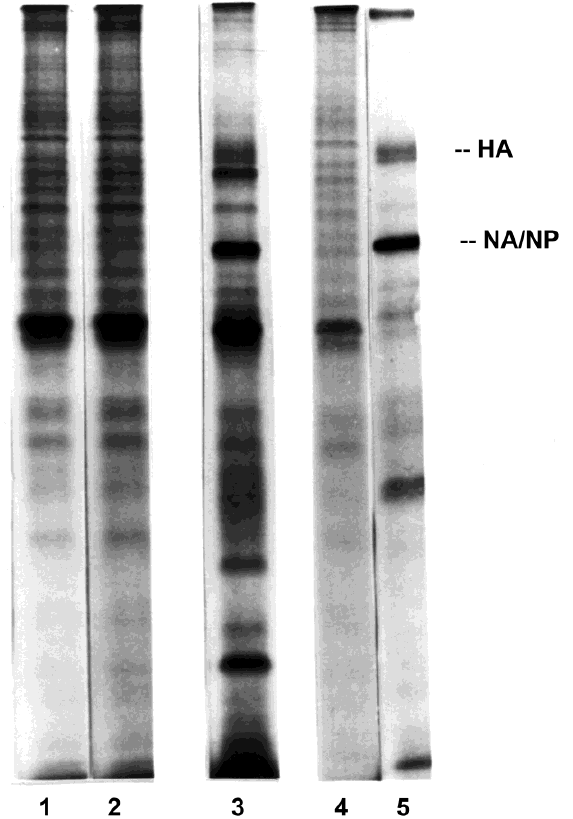
Figure 1. Influenza virus infection of purified PBMC subpopulations. Autoradiograms of purified human lymphocytes (lanes 1–3) or monocytes-macrophages (lanes 4 and 5) which were sham-exposed or exposed to influenza A/AA/Marton/43 H1N1 (MOI = 1.0) are shown. Lanes 1 and 2 show lysates from lymphocytes sham-exposed or exposed in the absence of monocytes/macrophages, respectively. Lane 3 shows lysate from lymphocytes exposed to virus in the presence of macrophages, and then purified by elutriation before radiolabeling. Lanes 4 and 5 show lysates from sham-exposed or exposed monocytes-macrophages, respectively. Each lane represents lysate from 2 × 10 6 cells. HA = hemagglutinin, at the 85 kD position; NA/NP = neuraminidase/nucleoprotein, which comigrate on SDS-PAGE, at the 60 kD position. In